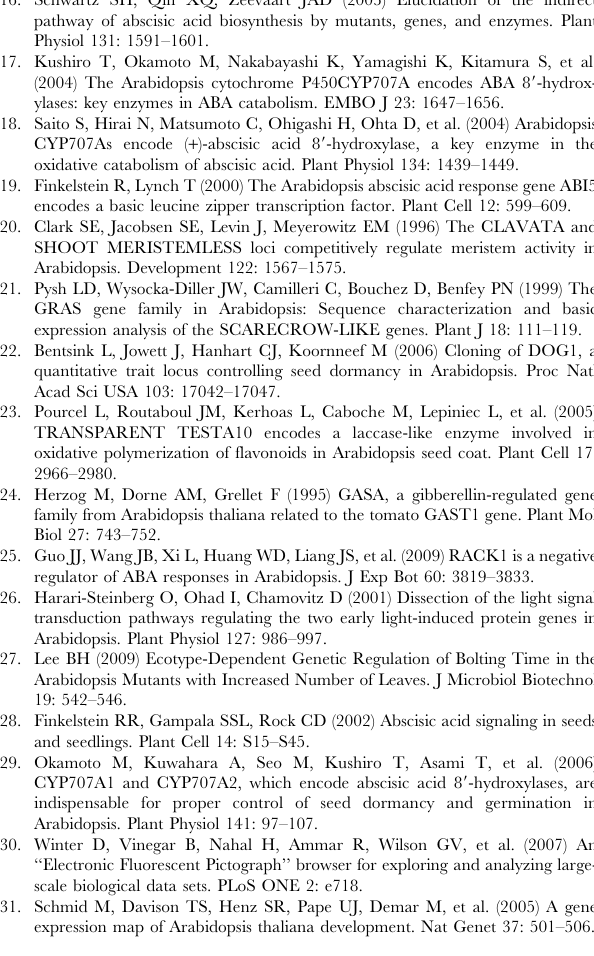
Figure S3 Phenotypes of all Col-0 amp1 mutant alleles studied in this work. Rosettes of Col-0 (A), amp1-1 (B), amp1-10 (C), amp1-11 (D), amp1-13 (E) and amp1-14 (F) at 21 days after sowing. Figure S4 GO classification of the genes differentially expressed in the microarray experiment. Classification of genes expressed highly in Col-0 than in amp1-1 (Col-0 . amp1-1), amp1-1 . Col-0, C24 . amp1-21 or amp1-21 . C24 using the Gene Ontology (GO) molecular function. The proportional representa- tion of the total gene set is shown. (TIF) Figure S5 Classification of the genes differentially expressed from the microarray experiment using TAG- GIT annotation. Classification of genes expressed more highly in Col-0 than in amp1-1 (Col-0 . amp1-1 ), amp1-1 . Col-0,